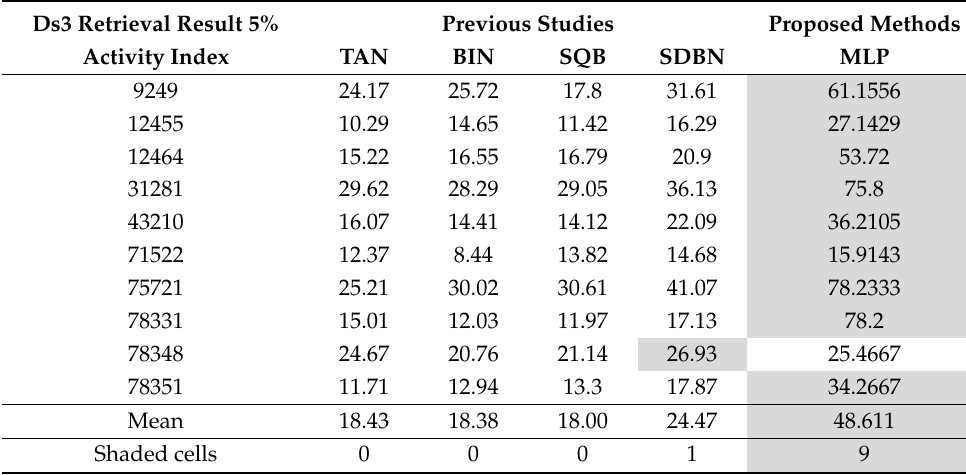
Table 11. Top 5% retrieval results for MDDR-DS3 dataset for descriptor (ECFC